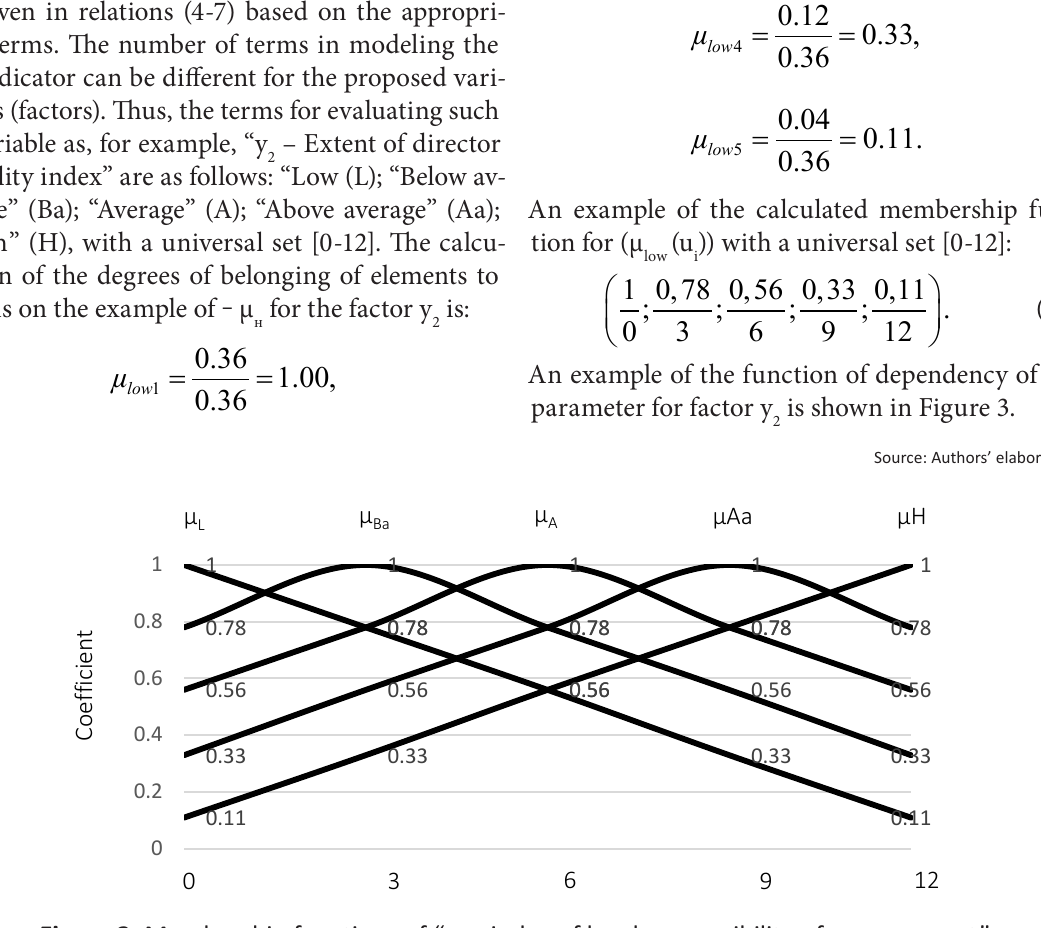
Figure 3. Membership functions of “y